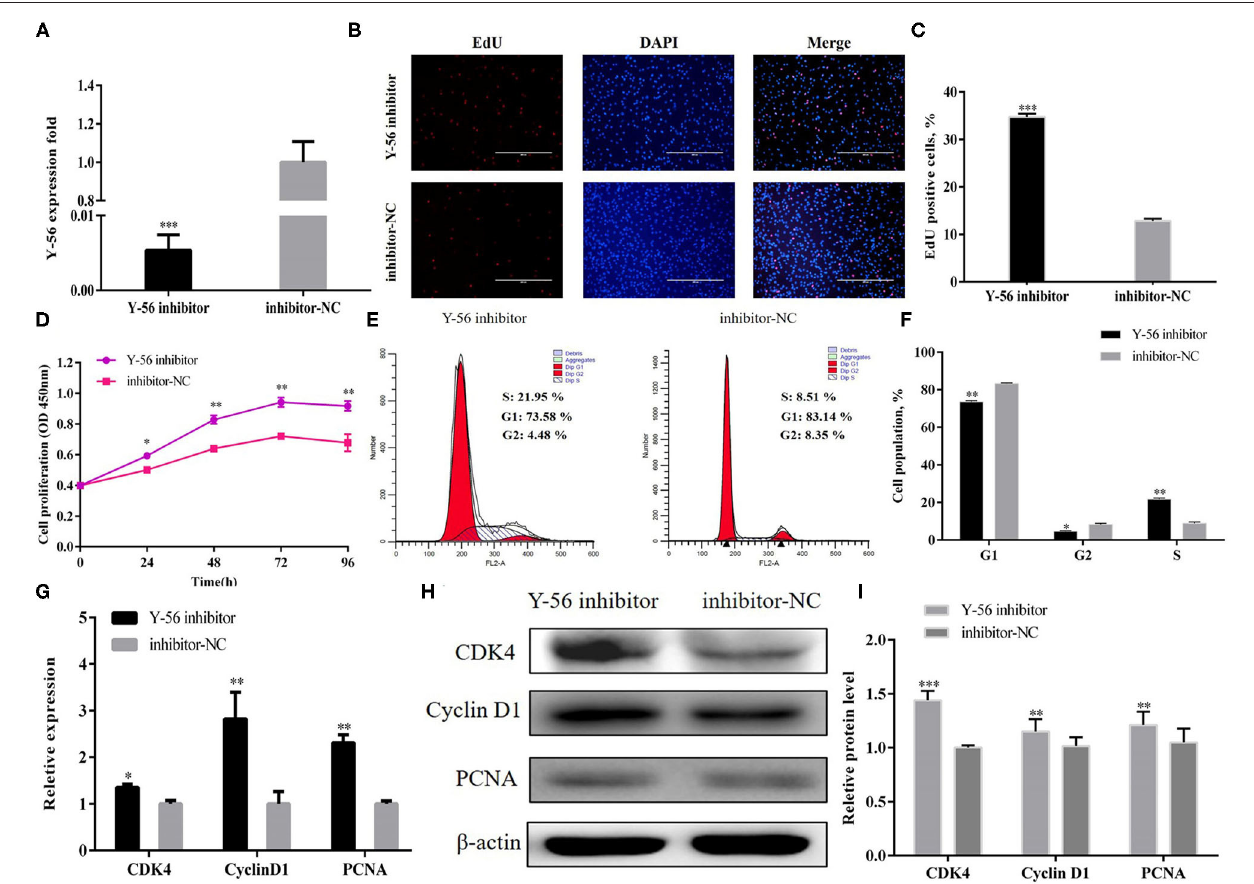
FIGURE 3 | Y-56 inhibition promoted PSC proliferation. (A) Transfection efficiency of Y-56 inhibitor. (B) EdU staining after the transfection of Y-56 inhibitor in PSCs. (C) Statistical results of EdU staining. (D) CCK-8 assay after the transfection of Y-56 inhibitor into PSCs. (E) Flow cytometry raw data of the cell cycle analysis of PSCs after Y-56 inhibition. (F) Statistical results of cell cycle analysis. (G) MRNA expression levels of cell cycle marker genes. (H,I) Protein levels of cell cycle marker genes. Results are shown as mean ± SEM, and the data are representative of at least three independent assays. Independent sample t -test was used to analyze the statistical differences between groups (* P < 0.05; ** P < 0.01, and *** P <